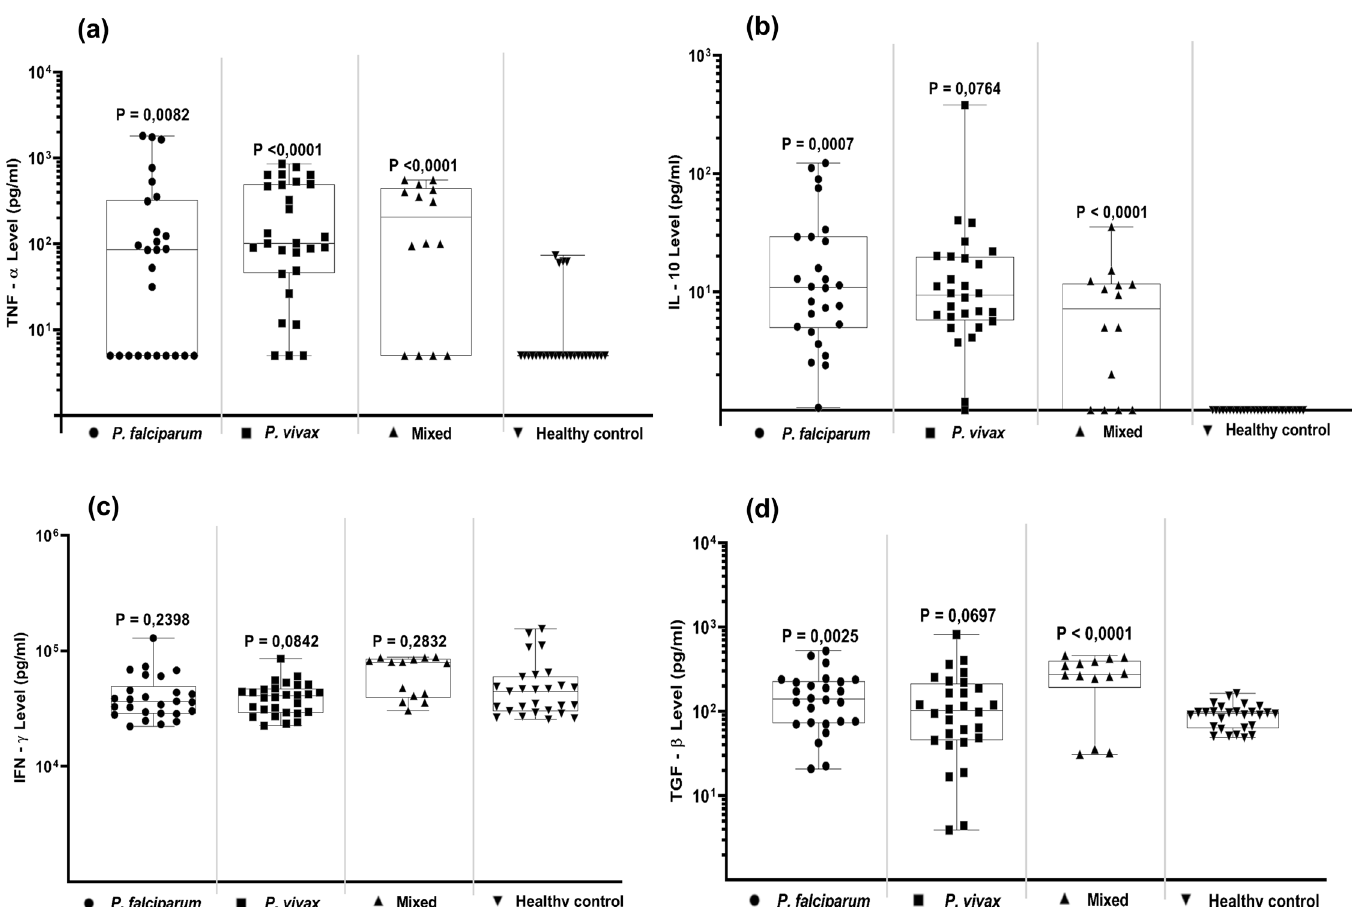
Fig 4. Quantitative cytokine levels in Malaria cases and controls; (a) TNF- α , (b) IL-10, (c) IFN- γ and (d) TGF- β . Statistical analysis was done by One-Way ANOVA for cases versus controls.